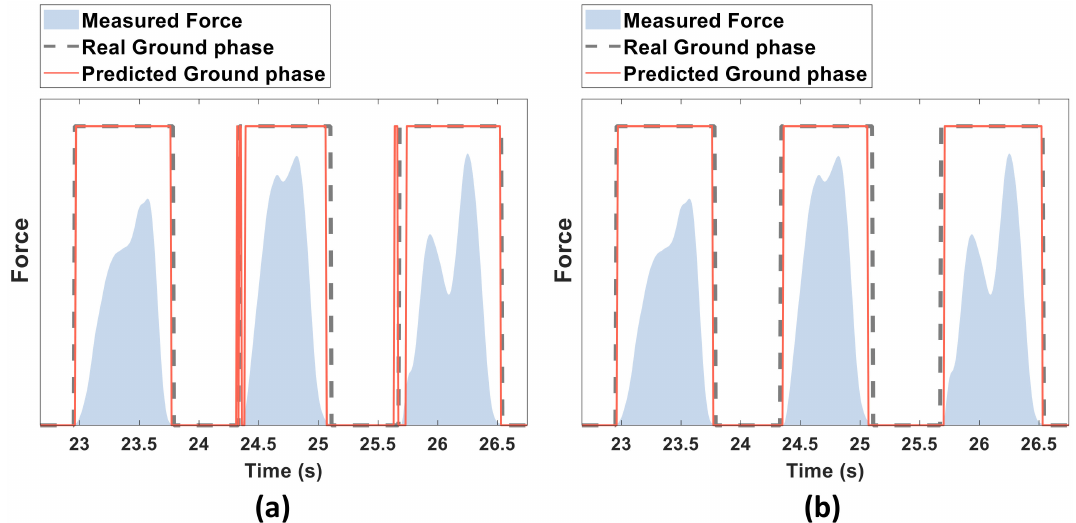
Figure 7. Example of the cane contact phase estimated by the proposed model before ( a ) and after ( b ) applying the voting